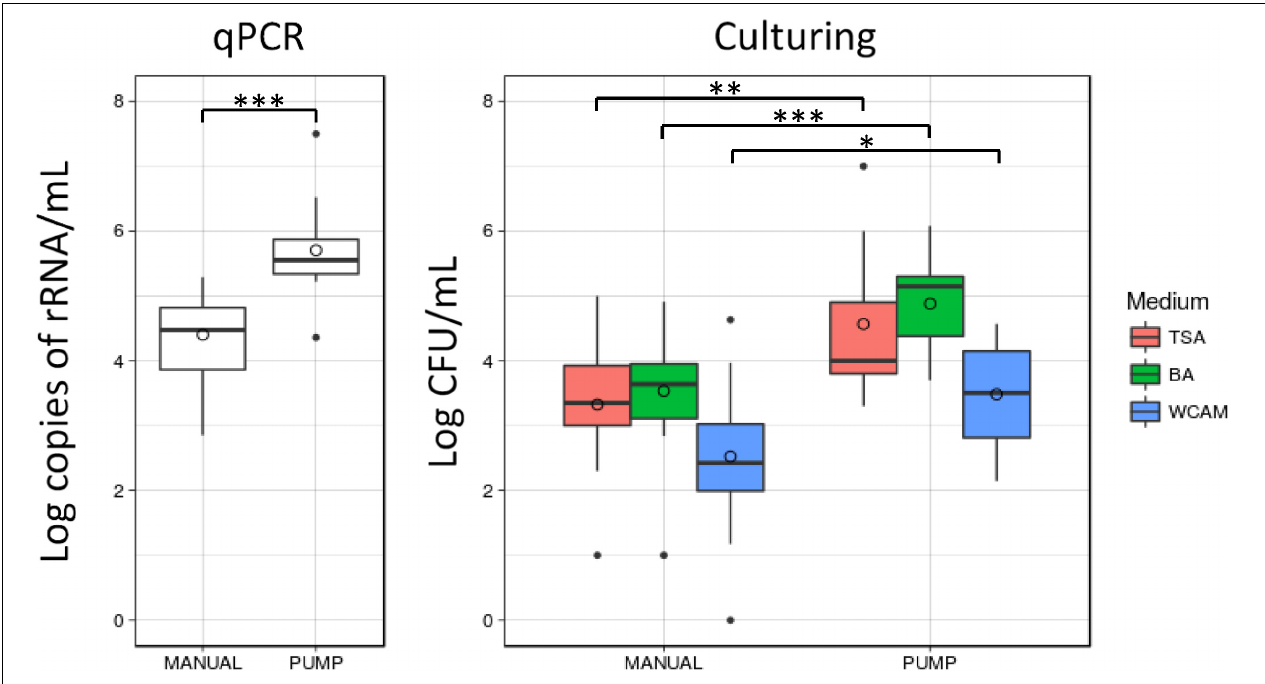
FIGURE 5 | Molecular- and cultivation-based quantification of bacterial load in human milk samples. Samples that mothers collected by manual expression had significantly lower content of bacterial DNA and decreased number of bacteria, grown on BA, TSA, and WCA-M. Statistical significance according to Mann–Whitney rank sum test: ∗ p < 0.05, ∗∗ p < 0.01, ∗∗∗ p <